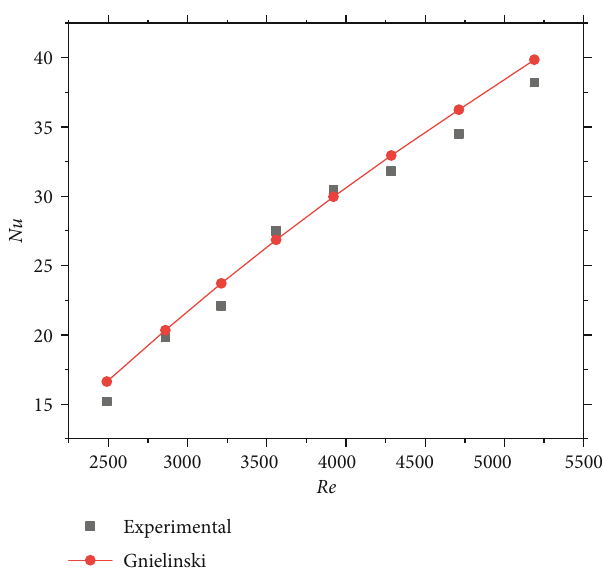
Figure 5: Comparison of the measured single-phase Nu with Gnielinski [39] prediction.